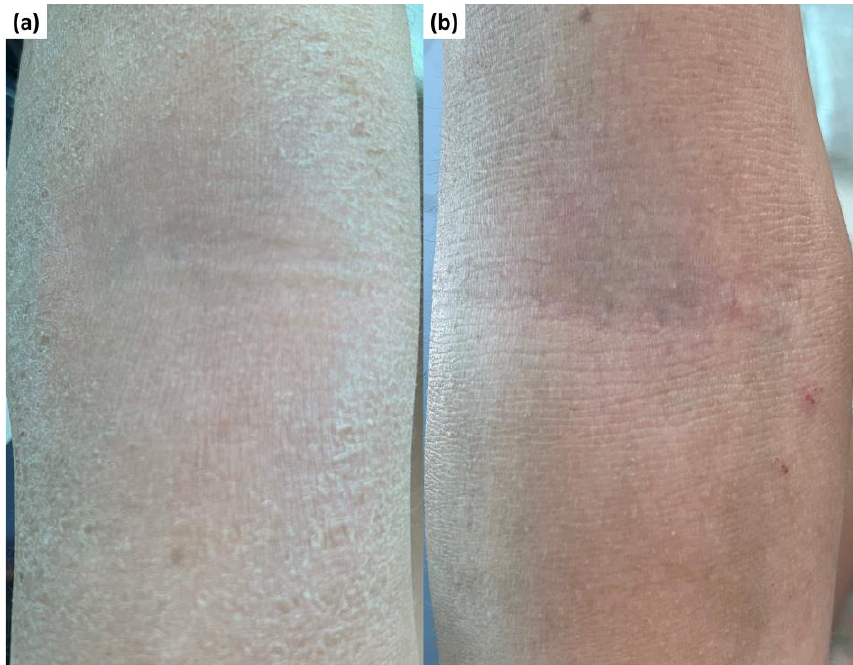
Figure 1. Clinical aspect of the skin ( a ) before treatment — chronic lichenified pruritic plaque associated with scraping injuries localized on the right antecubital fossae; ( b ) 3 weeks after starting treatment — favorable evolution of the lesion.